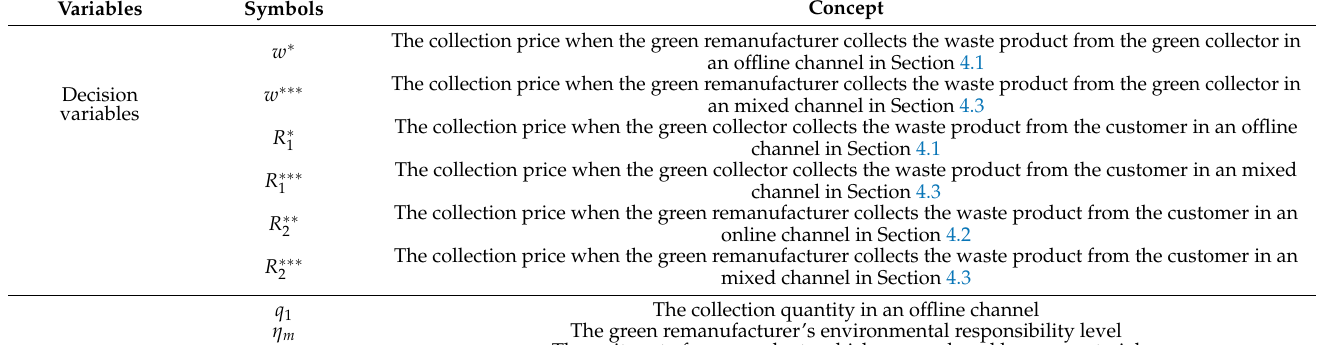
Table 1. The relevant parameters and decision variables.